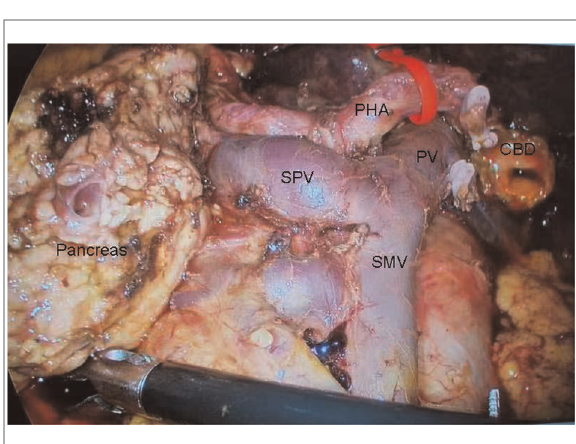
FIGURE 2 Regional anatomy in the laparoscopic pancreaticoduodenectomy. CBD, common bile duct; PHA, proper hepatic artery; PV, portal vein; SMV, superior mesenteric vein; SPV, splenic